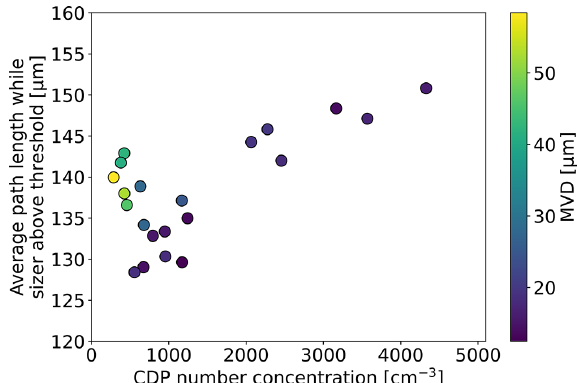
Figure B1. Average path length while sizer above threshold plotted against the number concentration for the SDS test points measured at Collins. The average path length is a measure similar to the av- erage transit time but multiplied with the airspeed in order to make test points with different airspeeds